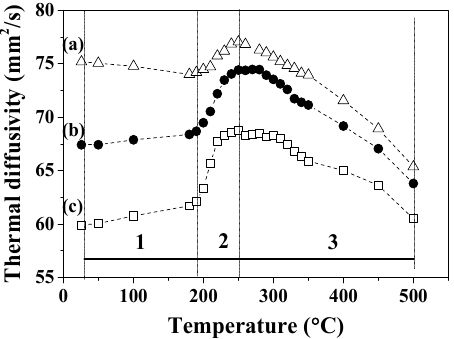
Figure 5. Thermal diffusivity changes of as-quenched samples according to increasing temperature: ( a ) Al-1.1Mg 2 Si, ( b ) Al-1.9Mg 2 Si, and ( c ) Al-3.5Mg 2 Si.